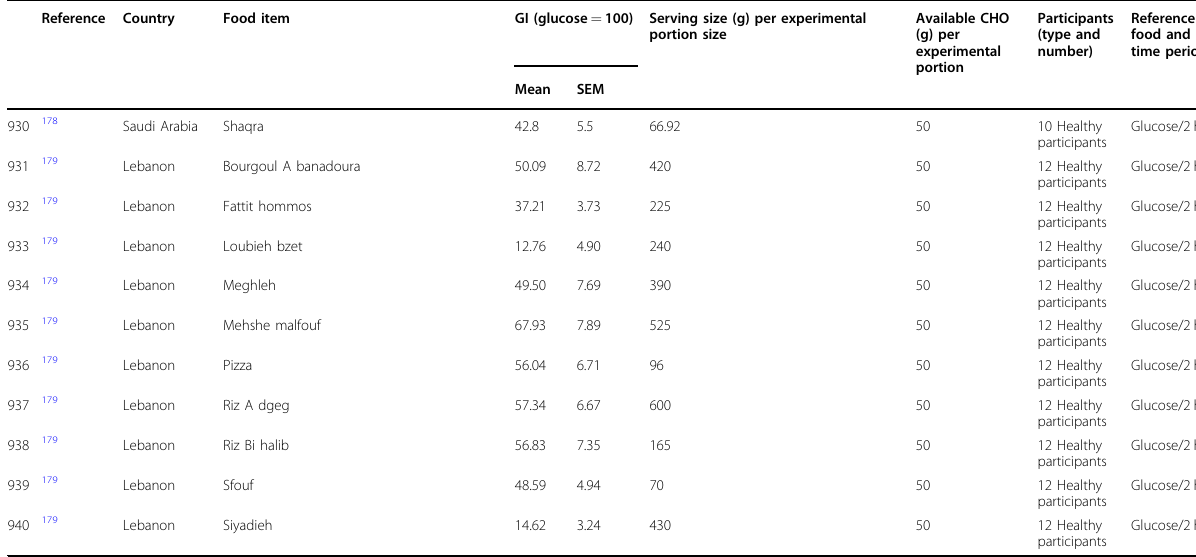
GI glycaemic index, NA not available.